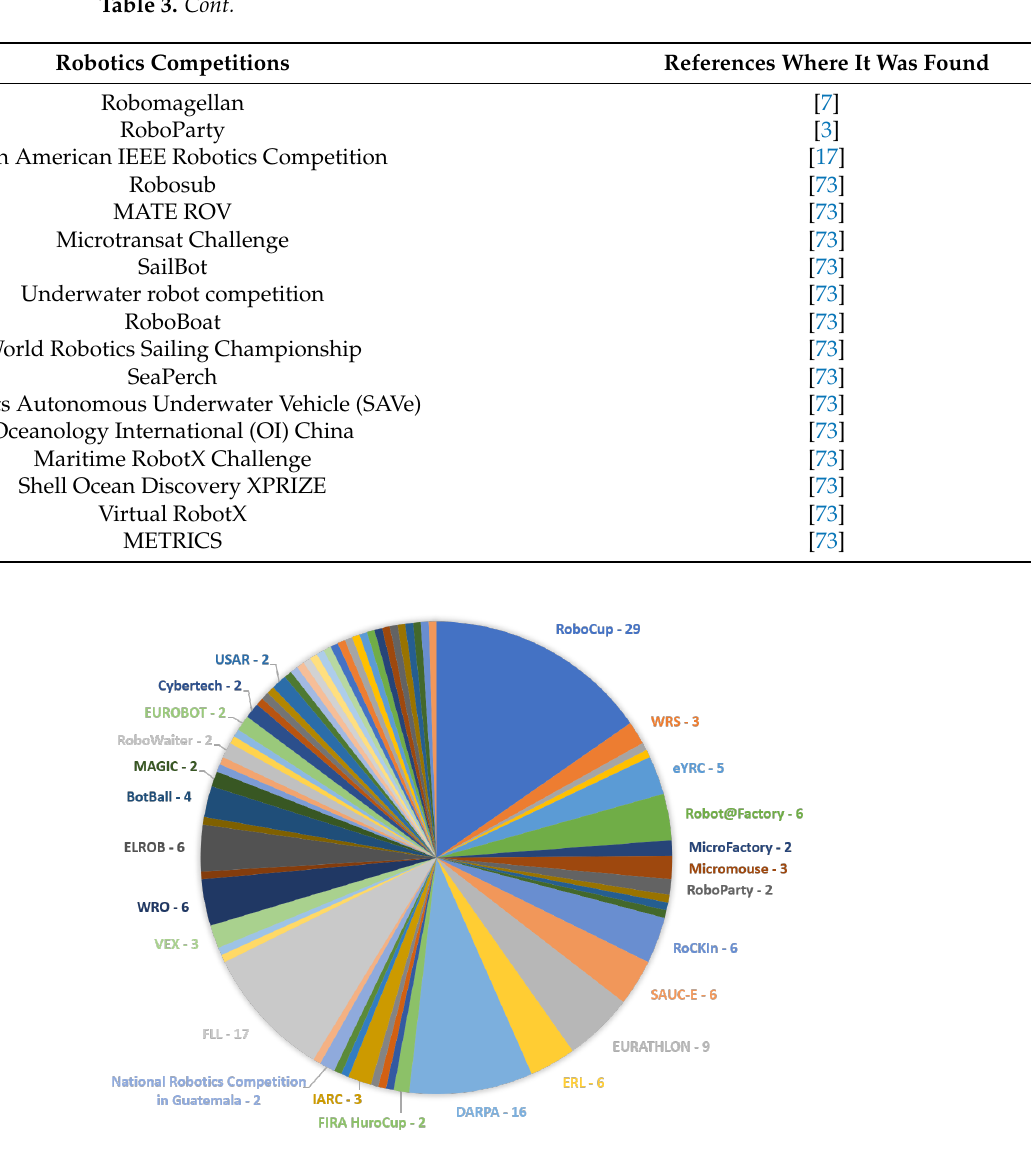
Figure 4. Robotics competitions per number of references in which they were found. Source: